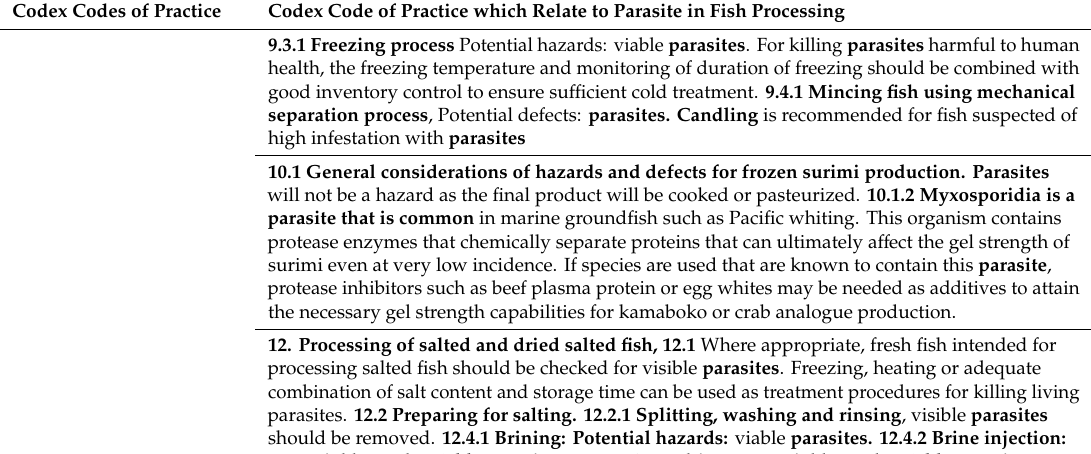
Codex Code of Practice which Relate to Parasite in Fish